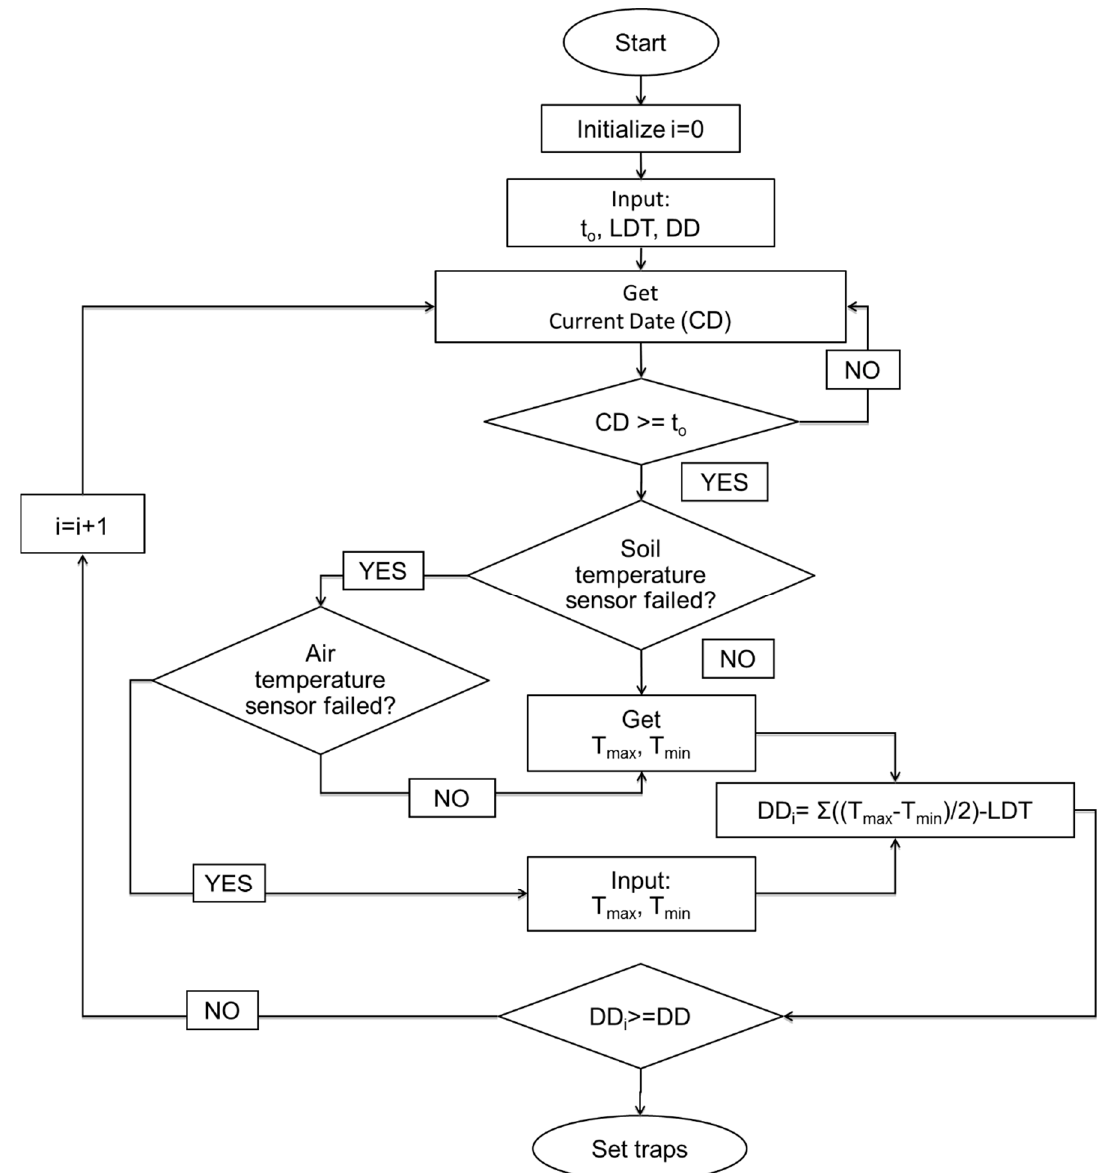
Figure 2. Algorithm of the DSS for trapping cherry fruit fly.